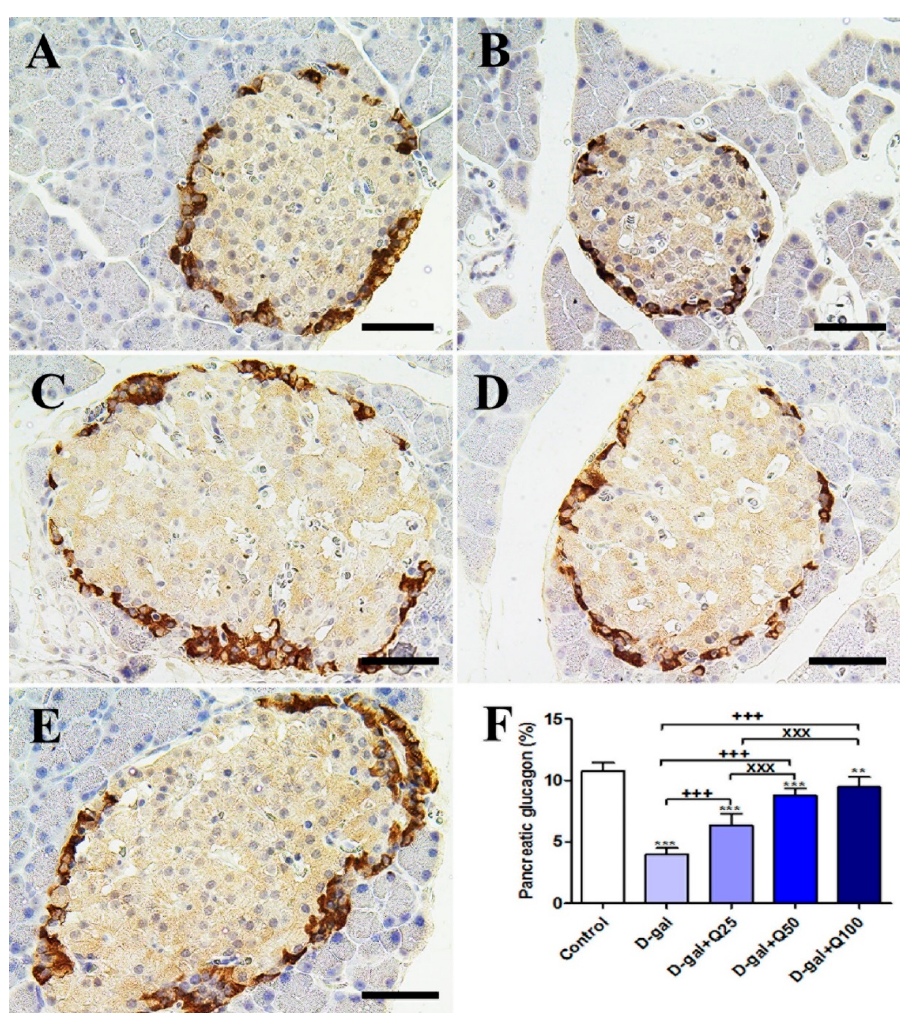
Figure 5. Immunohistochemical staining of rats’ pancreas with glucagon. ( A ) Negative control group. ( B ) D-gal group. ( C ) D-gal+Q25 group. ( D ) D-gal+Q50 group. ( E ) D-gal+Q100 group. ( F ) Quantification of glucagon in pancreatic islets of Langerhans in different groups. Scale bar = 50 µm . Data were analyzed with one-way ANOVA followed by Tukey’s multiple comparison test. ** p < 0.01 and ** *p < 0.001 vs control. +++ p < 0.001 vs D-gal. xxx p < 0.001 vs D-gal+Q25. Error bars represent mean ± SD.